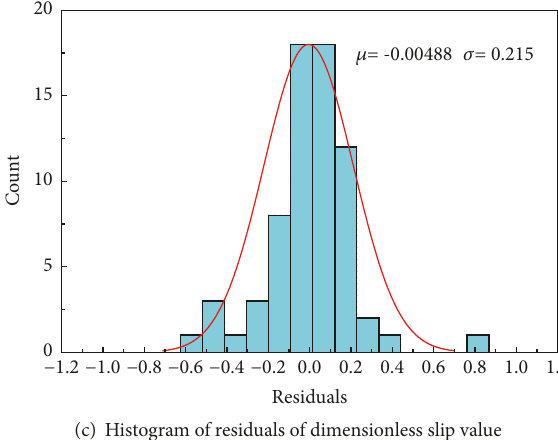
Figure 8: Dimensionless slip value corresponding to bond strength of beam-end specimens: (a) dimensionless slip value versus corrosion level; (b) residuals versus corrosion level; (c) histogram of residuals of dimensionless slip value.